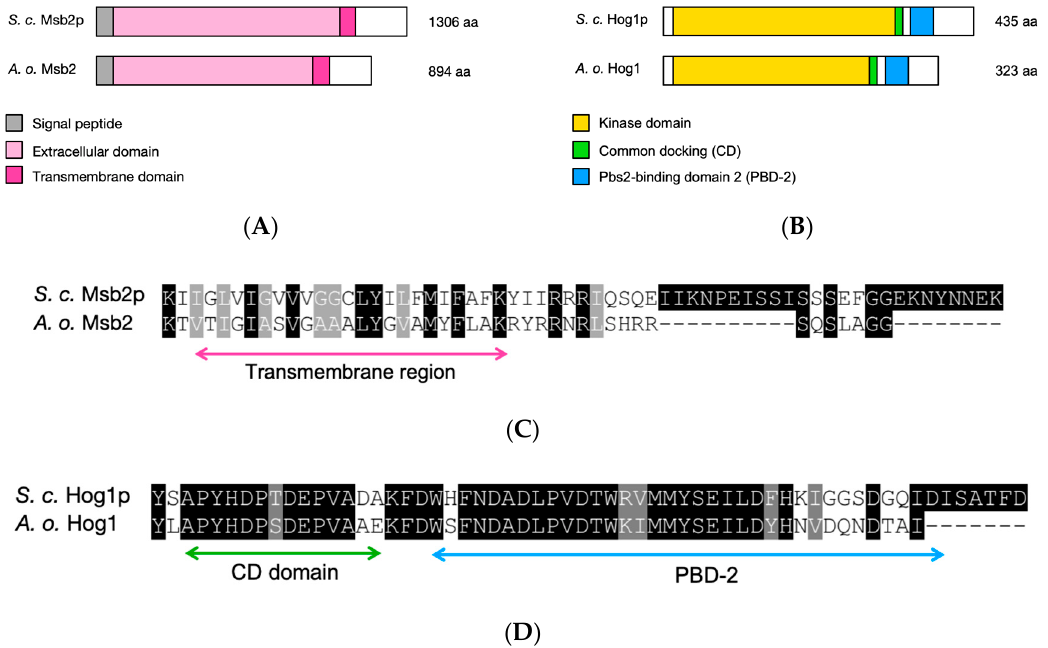
Figure 2. A. oligospora Msb2 and Hog1 are structural orthologs of the S. cerevisiae Msb2p and Hog1p. ( A ) Schematic representation of the domain structure of A. oligospora and S. cerevisiae Msb2 proteins. Both proteins share common features of signaling mucins, including a N-terminal signal peptide, a large extracellular domain, and one transmembrane that is closed to the C-terminus. ( B ) Schematic representation of the domain structure of A. oligospora and S. cerevisiae Hog1 proteins. Both proteins share common features, including a protein kinase domain, common docking (CD) domain and Pbs2-domain binding 2 (PBD-2). ( C ) Amino acid sequence alignment of the transmembrane region of the S. cerevisiae Msb2 (S. c. Msb2p) and A. oligospora Msb2. ( D ) Amino acid sequence alignment of the CD domain and PBD-2 of the S. cerevisiae Hog1 (S. c. Hog1p) and A. oligospora Hog1. Highly conserved residues are shaded in black; moderately conserved residues are shaded in gray.